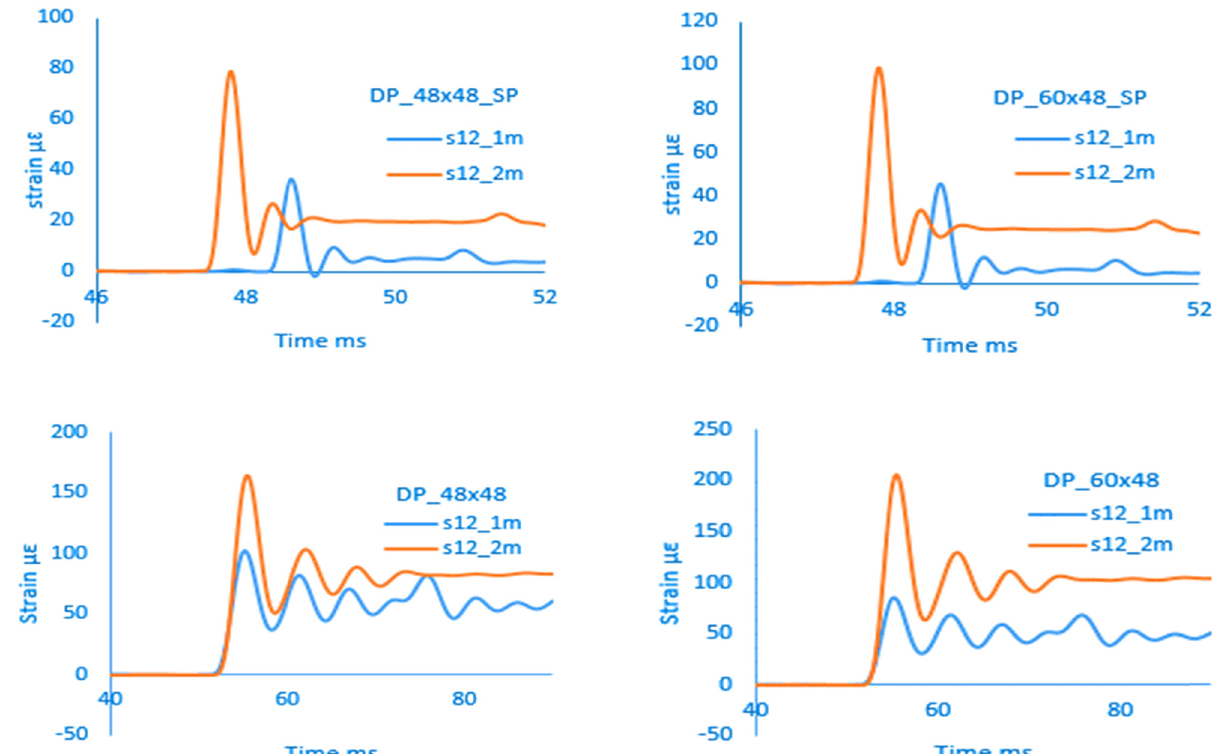
Figure 9: Concrete surface strain – time history at s12 location at di ff erent drop